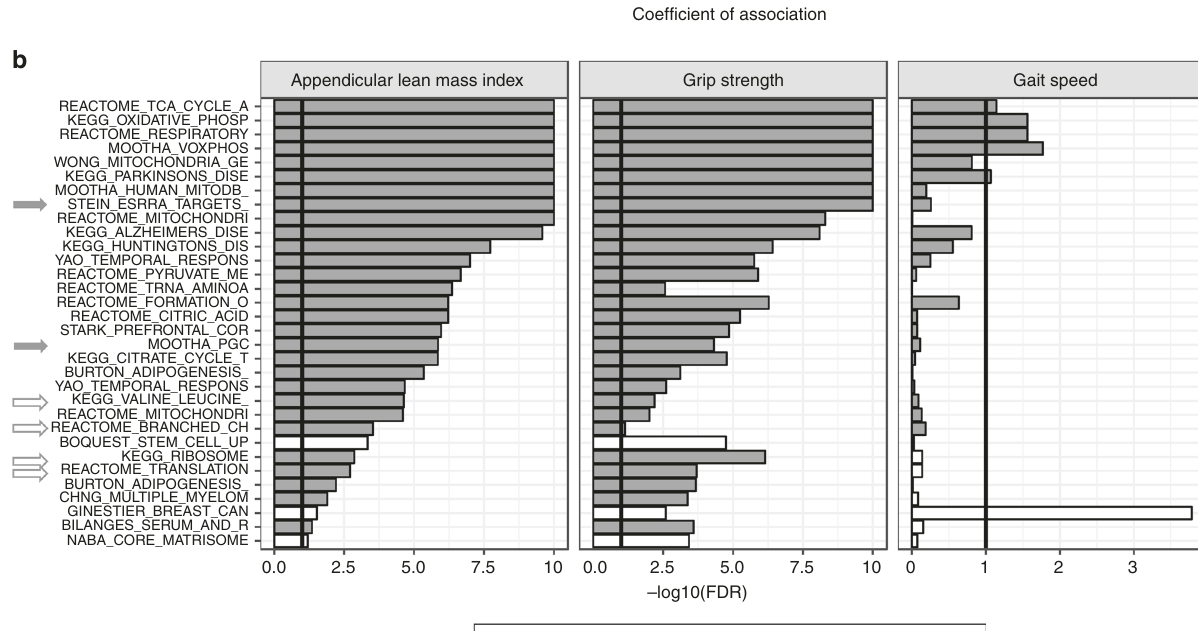
The molecular signatures of sarcopenia vs. healthy older people revealed low mitochondrial bioenergetic capacity as the dominant signal in the transition from physiological to pathological muscle aging across ethnic groups. Oxidative phosphorylation and mitochondrial energy homeostasis were the most perturbed biological processes associated with sarcopenia in all ethnicities, with bioenergetic alterations spanning across all mitochondrial